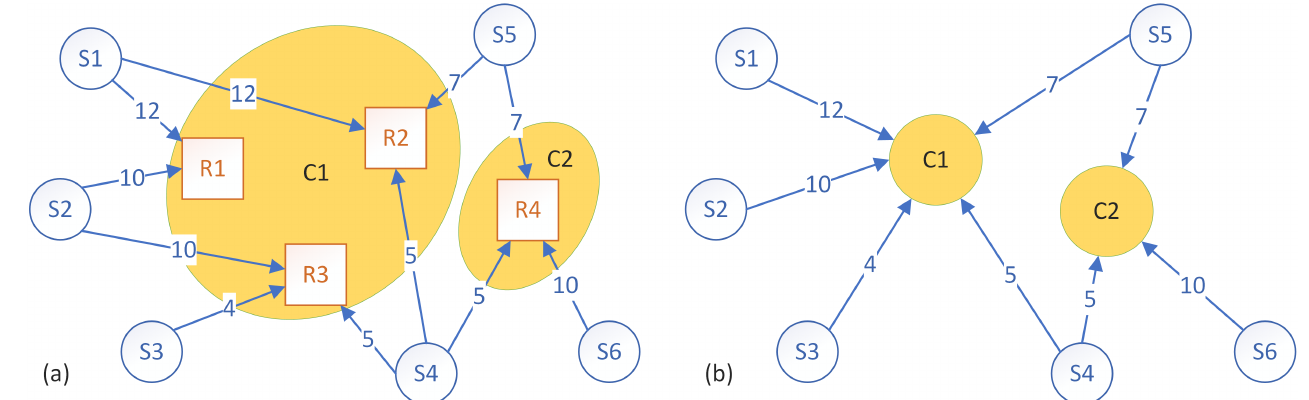
Figure 4. Example of clustering rules for the graph from Figure 2. ( a ) There are two clusters: C 1 with rules R 1 , R 2 and R 3 and cluster C 2 with rule R 4 . ( b ) The formed clusters receive the data from the connected sensors ( S ) only